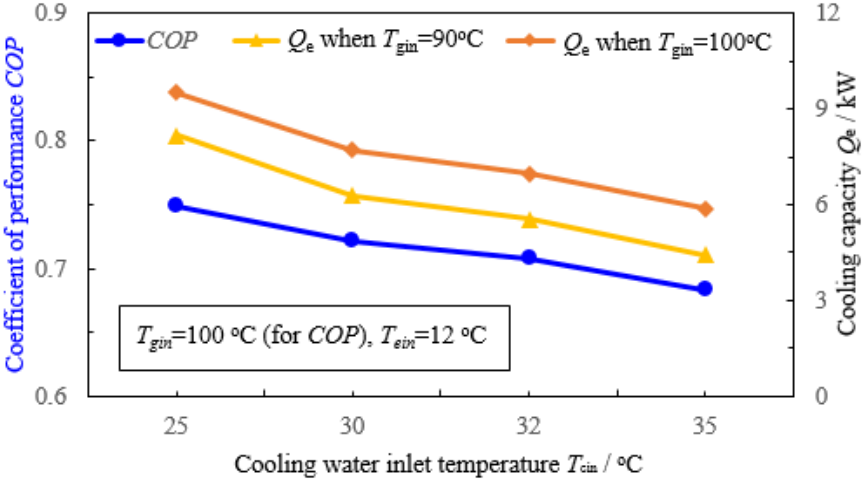
Figure 9. The effect of different T cin on the COP and cooling capacity.